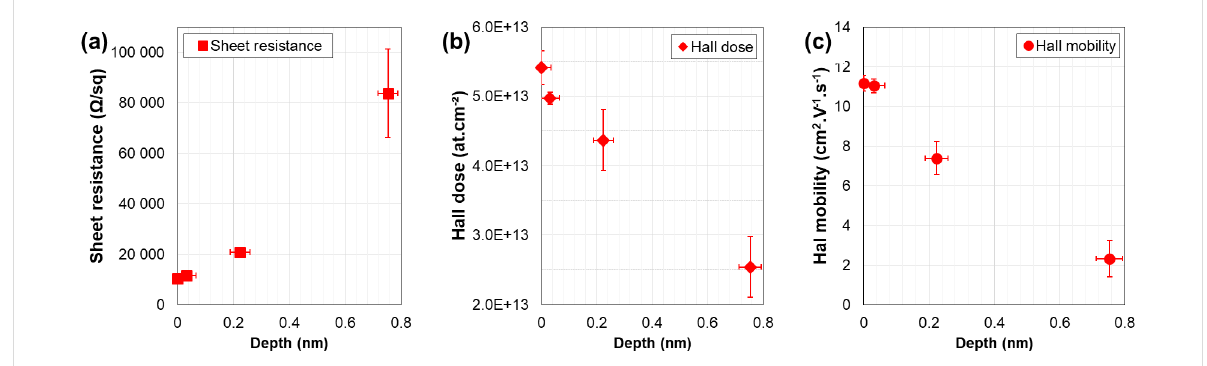
Figure 6: Hall effect measurements (raw data: (a) R S , (b) N H and (c) µ H ) of the SiGeOI sample ( x Ge = 0.25) implanted with boron and annealed at an energy of 0.68 J·cm − 2 as a function of the etched thickness (as measured by ellipsometry).